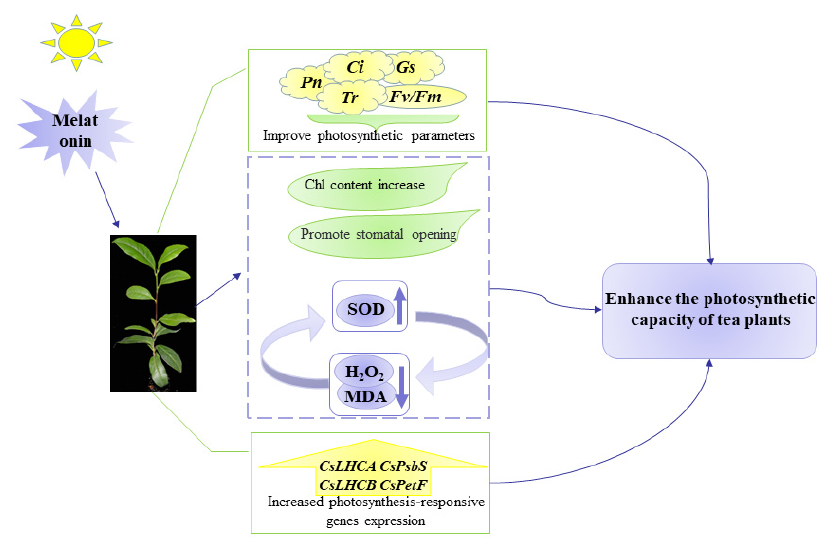
Figure 10. Possible mode of exogenous melatonin enhancing photosynthetic capacity of tea plants.